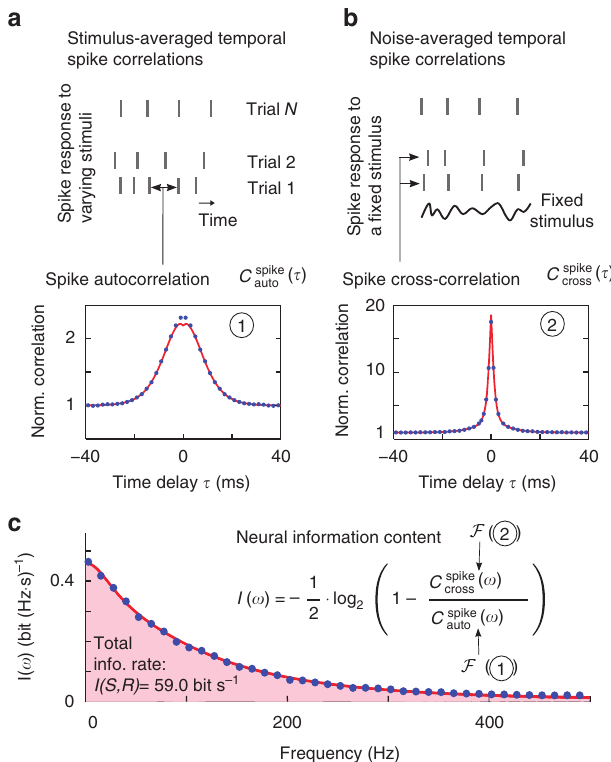
Figure 3 | Correlation theory of neural information content. Analytical predictions (red) and numerical results (blue) for a threshold-based spiking model of pyramidal neurons 20,21 . The temporal spike correlations were obtained by calculating analytically (red line) and numerically (blue dots) the spike correlation functions (1) and (2). ( a ) Temporal correlations within a spike train are captured via the spike autocorrelation function. Noise variability across trials with repeating stimulus was captured via the spike cross-correlation function ( b ). By inserting the Fourier transformations ( F ) of the two functions (1) and (2) into equation (4), we obtain the exact information rate per frequency I ( o ) and the total information rate of 59.0bits s (cid:2) 1 shown in c . Parameter values as in Table 1. Spike correlation functions are normalized by the square of the firing rate to help compare auto- and cross-correlations.